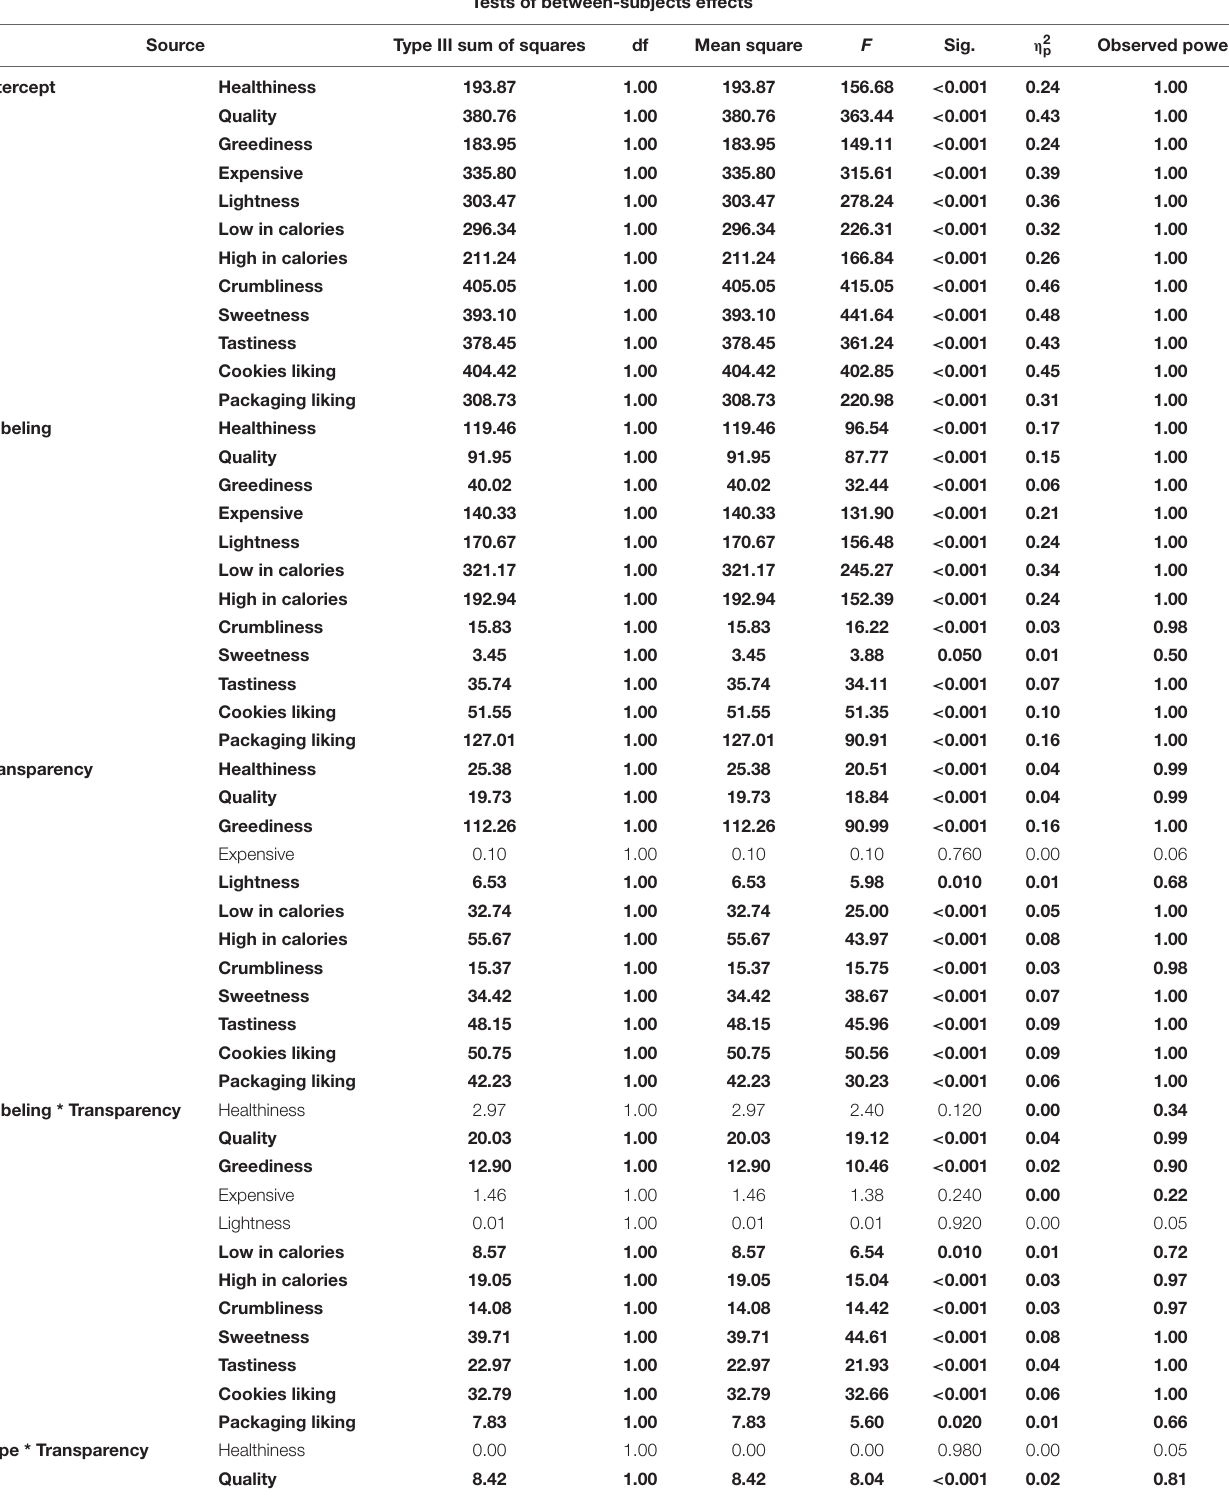
TABLE 4 | Summary of the main effects and